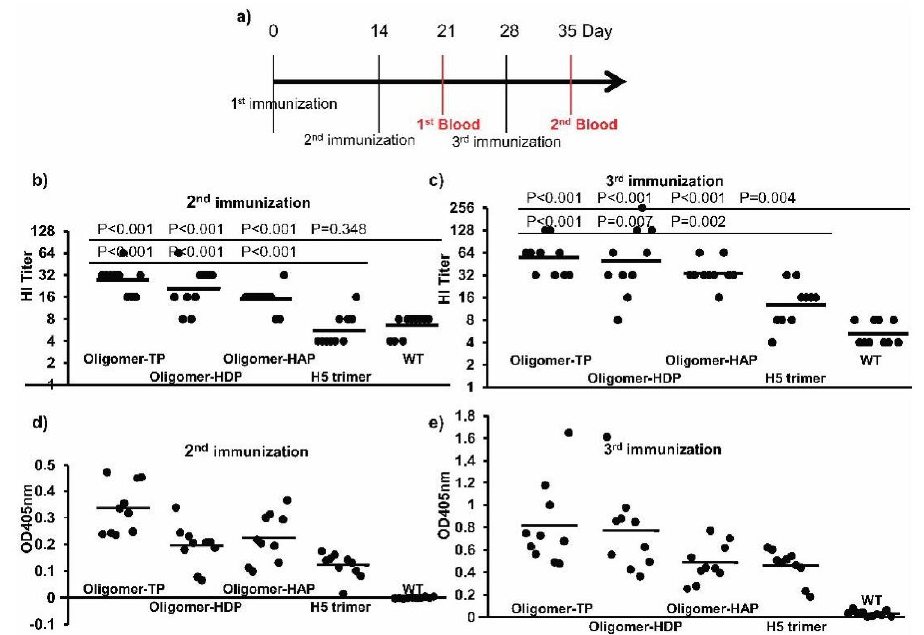
Figure 5. Immune responses of mice immunized with plant crude extracts containing H5 trimers and H5 oligomers. ( a ) Mouse immunization and bleeding schedule. Each mouse was immunized either with crude extracts containing 0.1 µ g (oligomer-TP, oligomer-HDP, oligomer-HAP or H5 trimer, respectively) formulated with the Emulsigen ® -D adjuvant at 20% final concentration. In the negative control group, mice were injected with N. benthamiana wild-type leaf extracts formulated with the Emulsigen ® -D adjuvant at 20% final concentration. Mice were vaccinated with the formulated vaccines at days 0 and boosted at days 14 and 28. Sera were collected one week after the second and third immunizations. ( b , c ) Antibody responses estimated by hemagglutination inhibition assay after the second and third immunization. Measurement of neutralizing antibodies raised by injection of di ff erent extracts into mice after two ( b ) and three ( c ) immunizations by hemagglutination inhibition assay. Single dots represent the HI titers of single serum samples and bars are the geometric mean titers of each test group. ( d , e ) Antibody responses estimated by indirect ELISA after the second and third immunization. Measurement of antibodies raised by injection of di ff erent extracts into mice after two ( d ) and three ( e ) immunizations by indirect ELISAs. Single dots represent the OD405nm value of single serum samples and bars are the average OD405nm values of each test group.